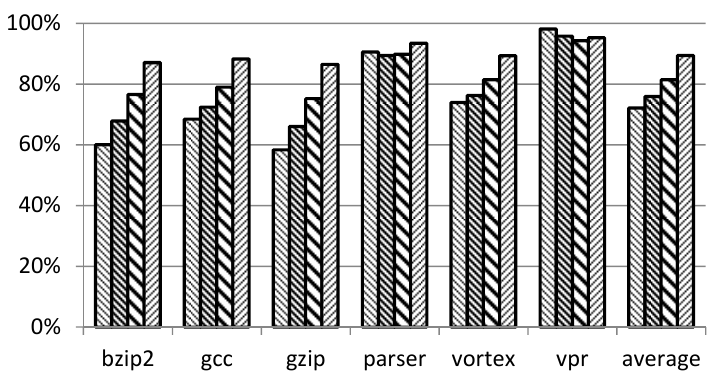
Figure 8. Relative power consumption (50%-scenario,